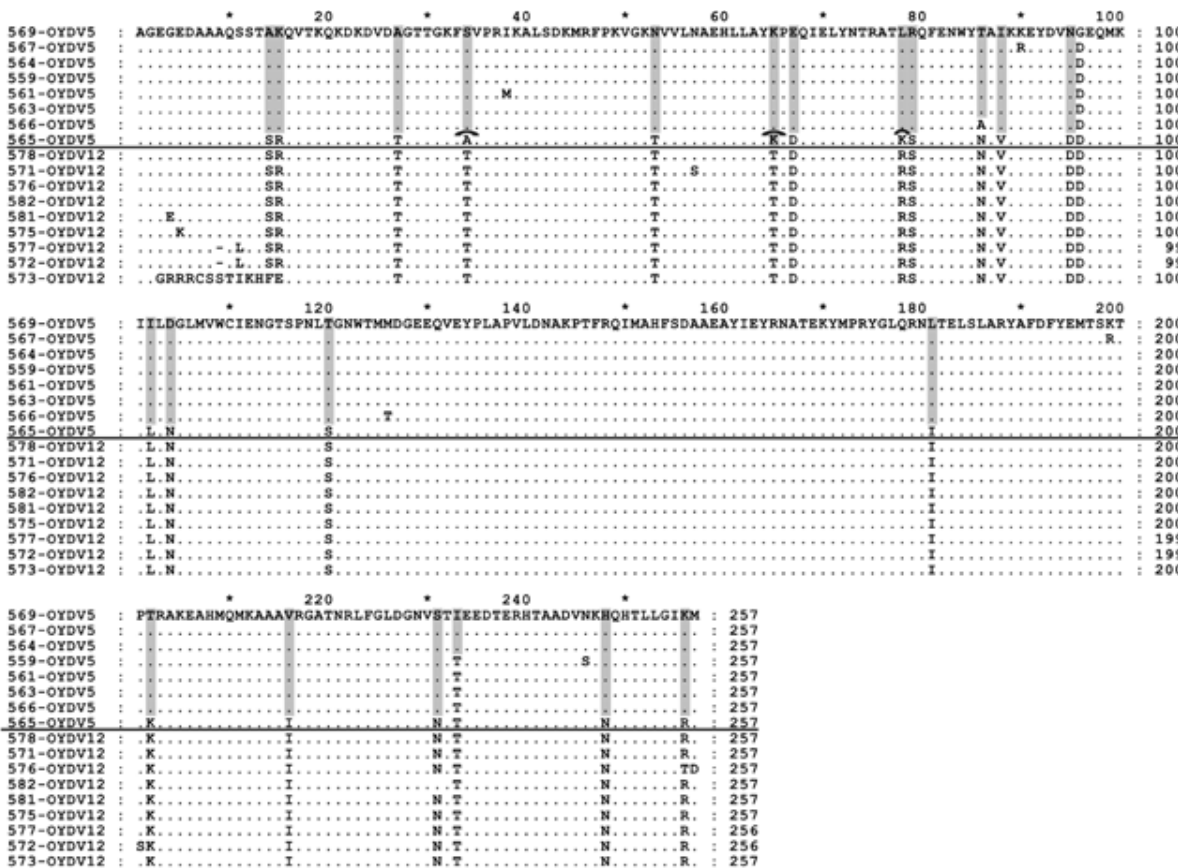
Figure 3. Amino acid sequence of the coat protein of Onion yellow dwarf virus (OYDV) isolates from Argentinian garlic (OYDV5), and Chenopodium quinoa (OYDV12) mechanically inoculated with crude extract of the Argentinian garlic. Twenty two major mutated sites are highlighted. The three mutations distinguishing the 565-OYDV5 clone from the garlic and C. quinoa isolates are capped. 559-582: Serial numbering of OYDV cDNA clones. Sequences have been deposited in GenBank under accession numbers